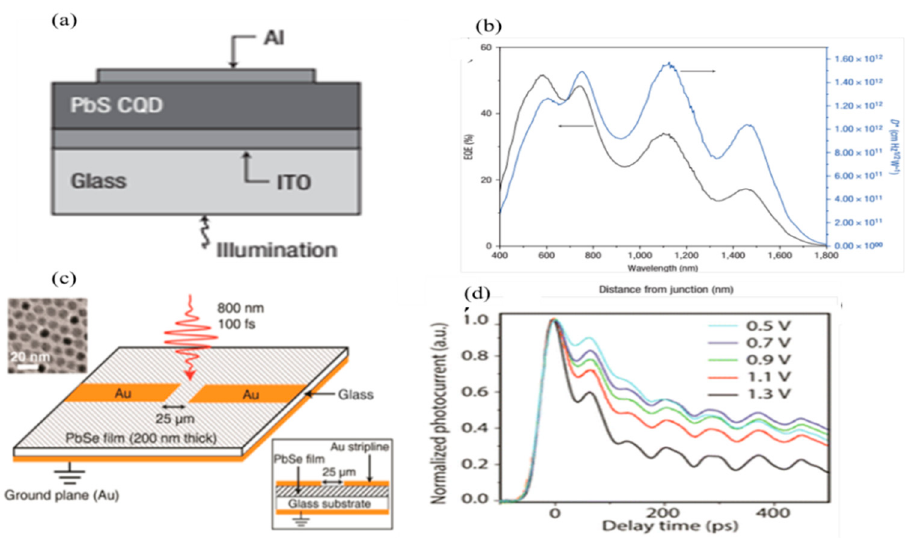
Figure 3. ( a ) The structure and ( b ) quantum efficiency of the Schottky diode Al/PbS CQDs of a Schottky diode photodetector based on a PbS CQD film (reproduced with the permission of Reference [69] Copyright 2009, Nature Publishing Group). ( c ) The structure of a vertically stacked photoconductive detector based on PbSe CQDs and ( d ) the response time at a different applied voltage (reproduced with the permission of Reference [75], Copyright 2016, American Chemical Society).